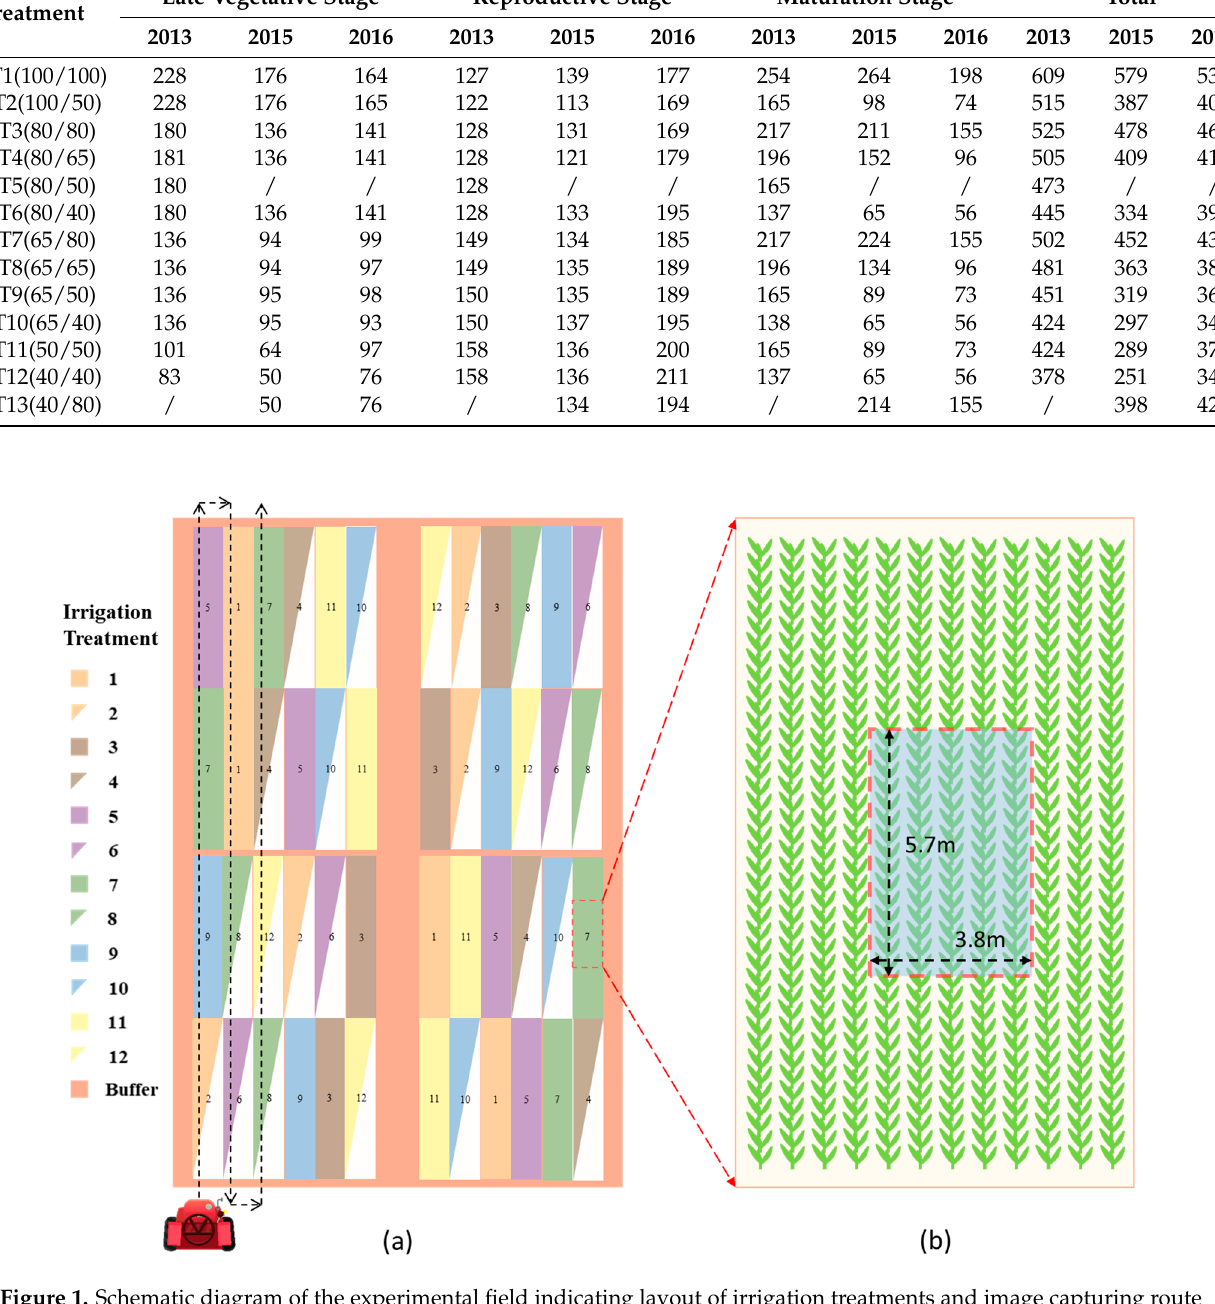
Table 1. Irrigation treatment and total irrigation and precipitation amount (mm) in different growing stages. In 2015 and 2016, irrigation treatment 5 (TRT5) (80/50) was replaced by TRT13 (40/80). Treatment